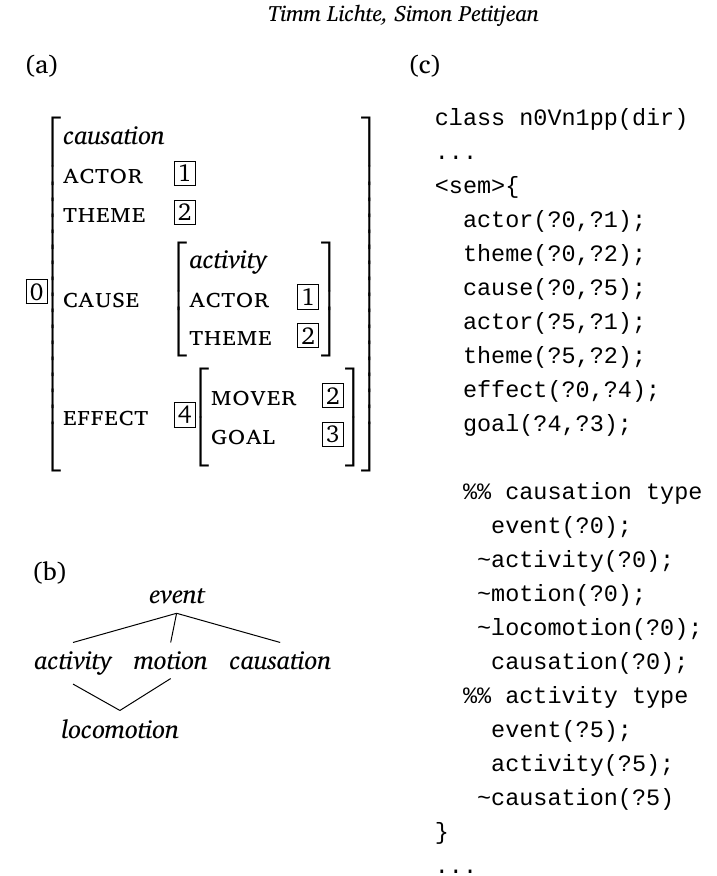
Figure 10: The feature structure of n0Vn1pp(dir) (repeated from Figure 4), the global type hierarchy (partially repeated from Figure 2), and its reformu- lation inside the <sem>